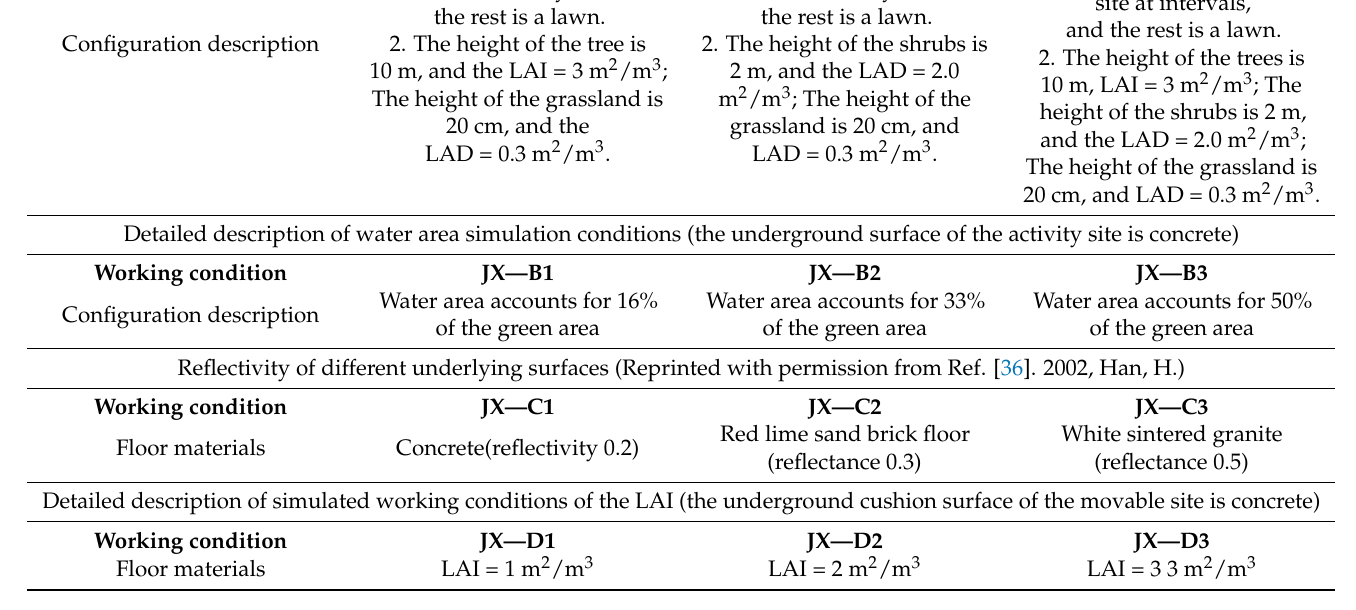
Table 4. Schematic diagram of factor level and plane of orthogonal test.